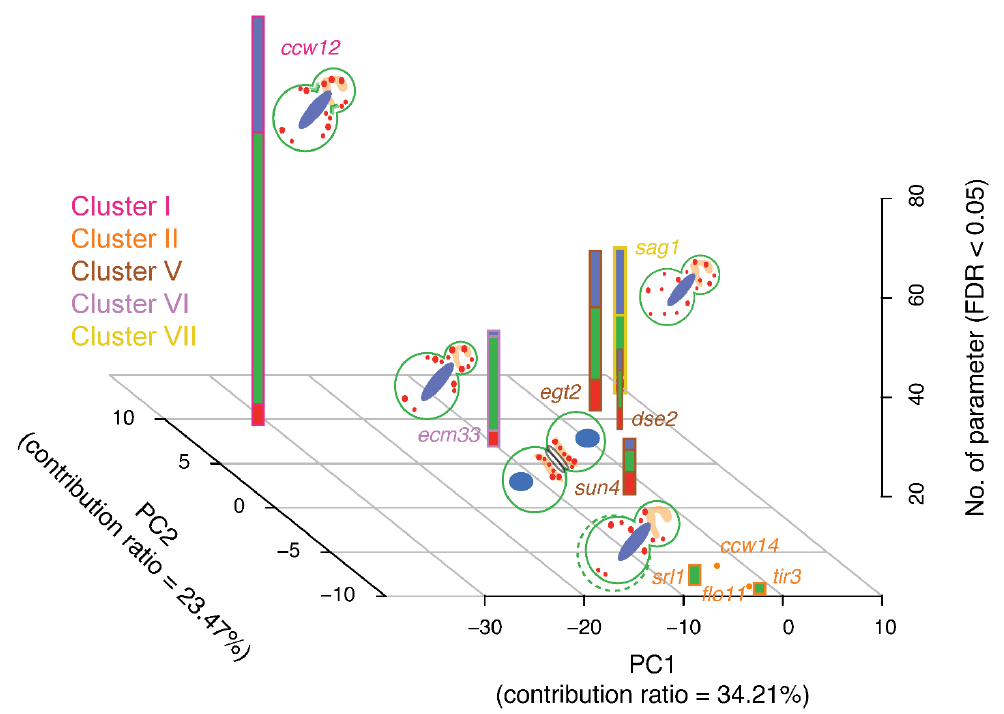
Figure 6. Schematic representation of the mannoprotein responsibility matrix. Stacked bars show the numbers of disturbed CalMorph parameters (Wald test, FDR = 0.05) related to actin, the cell wall, and the nucleus (illustrated in red, green, and blue, respectively) in mutants of clusters I, II, V, VI, and VII. Prominent implications of morphological defects caused by each mutation are illustrated in a small budding yeast cell where actin, the cell wall, and the nucleus are shown in red, green, and blue, respectively. Green dashed circle represents larger mother cell. Mutants are color-coded according to Gaussian mixture model clustering of morphological data (see Figure 1).